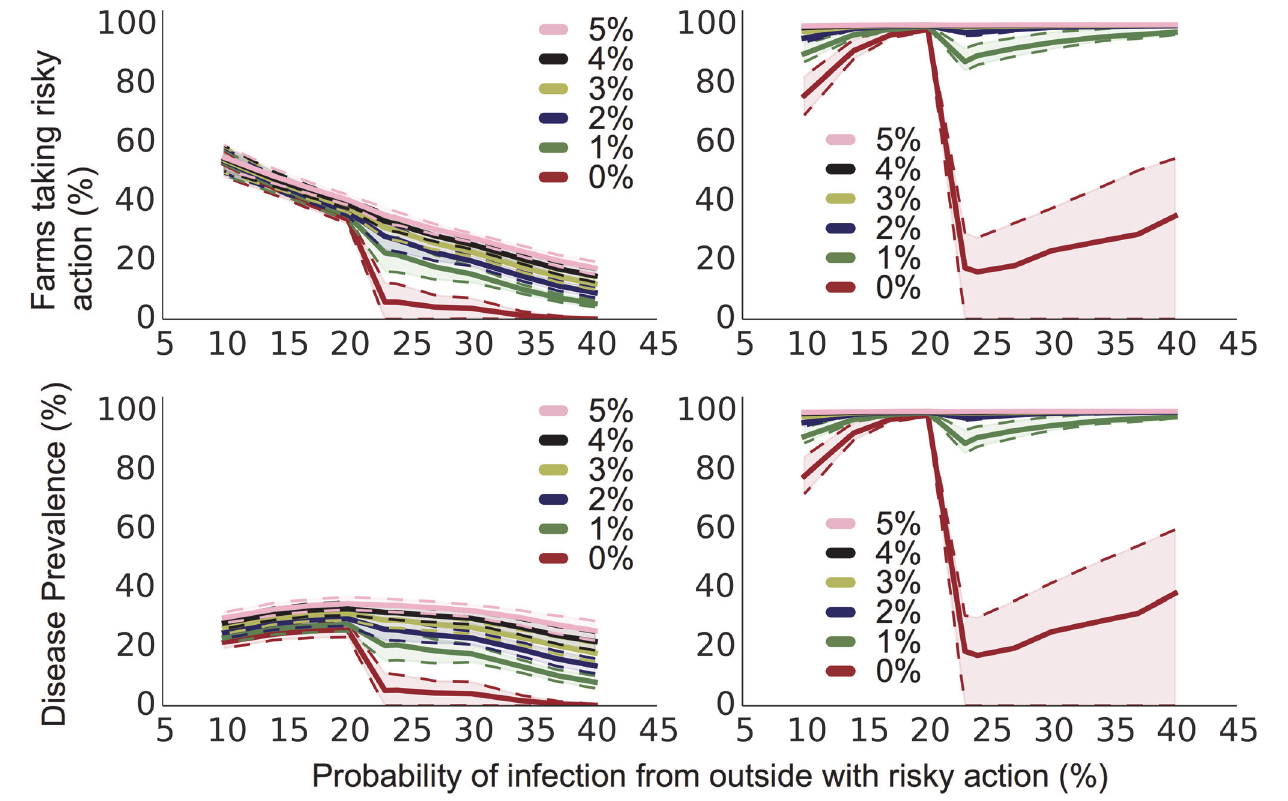
Fig 3. The disease prevalence ( bottom ) and percentage of farms taking the risky action ( top ) over a range of probabilities of bringing in the disease with the risky action. Each line represents a different percentage of noncooperative farms. In the left column we show results from simulations of idealist farms which compare their payoffs to a set general payoff estimate, and on the right results from simulations of realist farms that compare only to payoffs they have experienced. 95% confidence envelopes are plotted in pale shading around each line bounded by dotted lines.